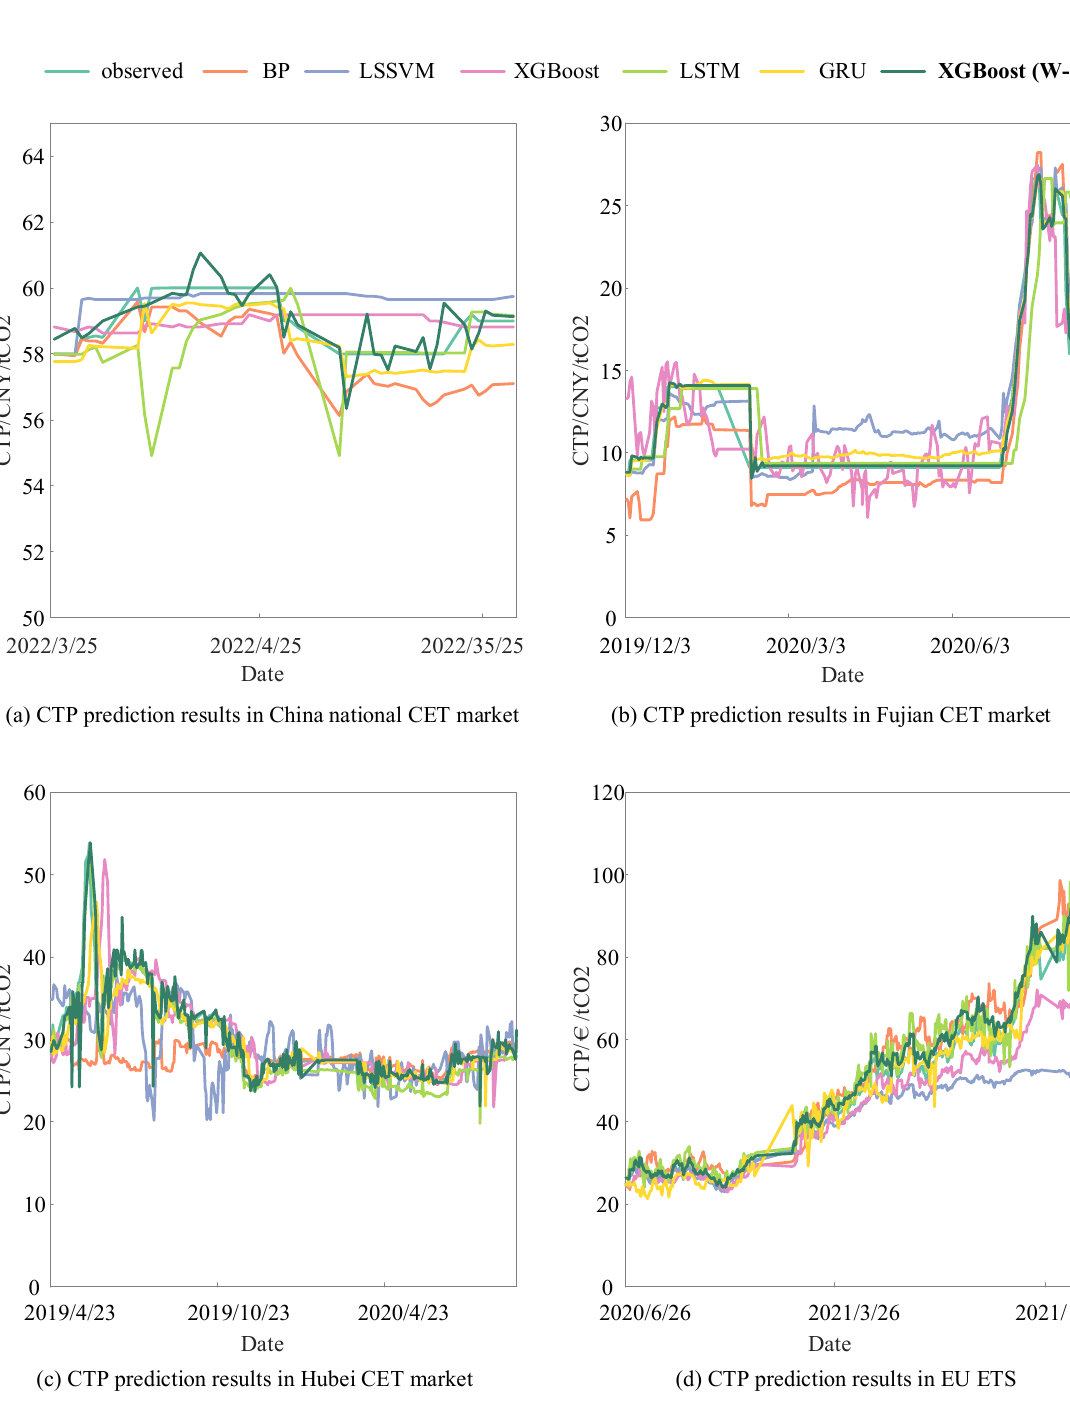
Figure 3. CTP prediction results for different forecasting methods.